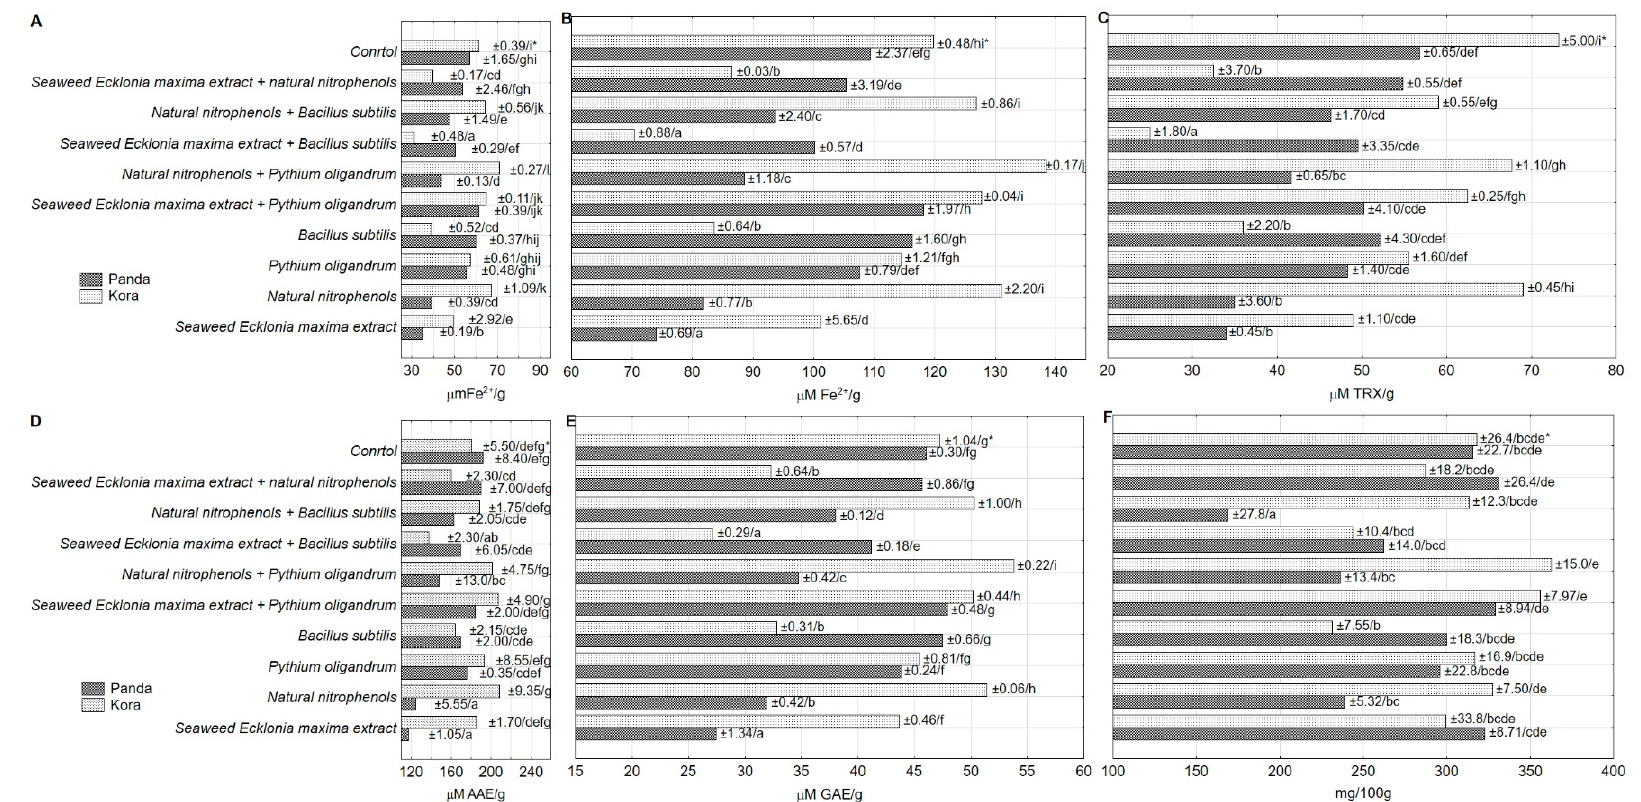
Figure 1. Effect of the treatment on antioxidant activity (Ferric Reducing Antioxidant Power (FRAP) 4 ′ ( A ), FRAP 60 ′ ( B ), 1,1-diphenyl-2-picrylhydrazyl (DPPH) ( C ), Water-Soluble Antioxidant Capacity ACW ( D )), total polyphenols ( E ), and rutoside ( F ) content in the buckwheat sprouts cvs. Panda and Kora. * standard error of mean/homogeneous groups.